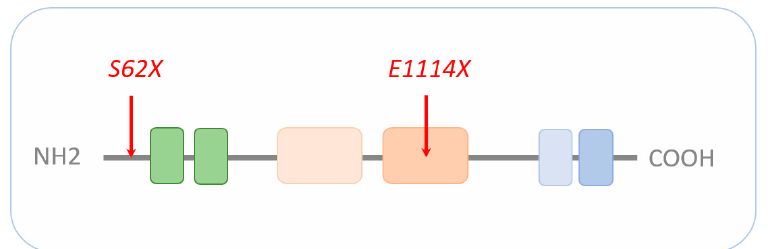
Figure 2. Schematic representation of CHD8 . The signature motif of the entire CHD family is an N-terminal tandem chromodomain (green boxes) responsible for chromatin binding. The central SNF2-family ATPase domain consists of two lobes (light beige and beige box), with each containing two tandem RecA-like folds parts known as DExx and HELIC. The ATPase domain uses ATP hydrolysis to guide toward translocation down the DNA minor groove. The C-terminus contains functional motifs, such as SANT (light blue) or BRK (blue) domains. SANT domains support association with histone tails, while the BRK domain is also found in several SWI/SNF complexes. The localization of the CHD8 loss-of-function mutations S62X and E1114X (see Section 5.5) are highlighted by red arrows. Drawing is not to scale and refers to the long form of CHD8. Schematic adapted from [21], attribution CC BY.